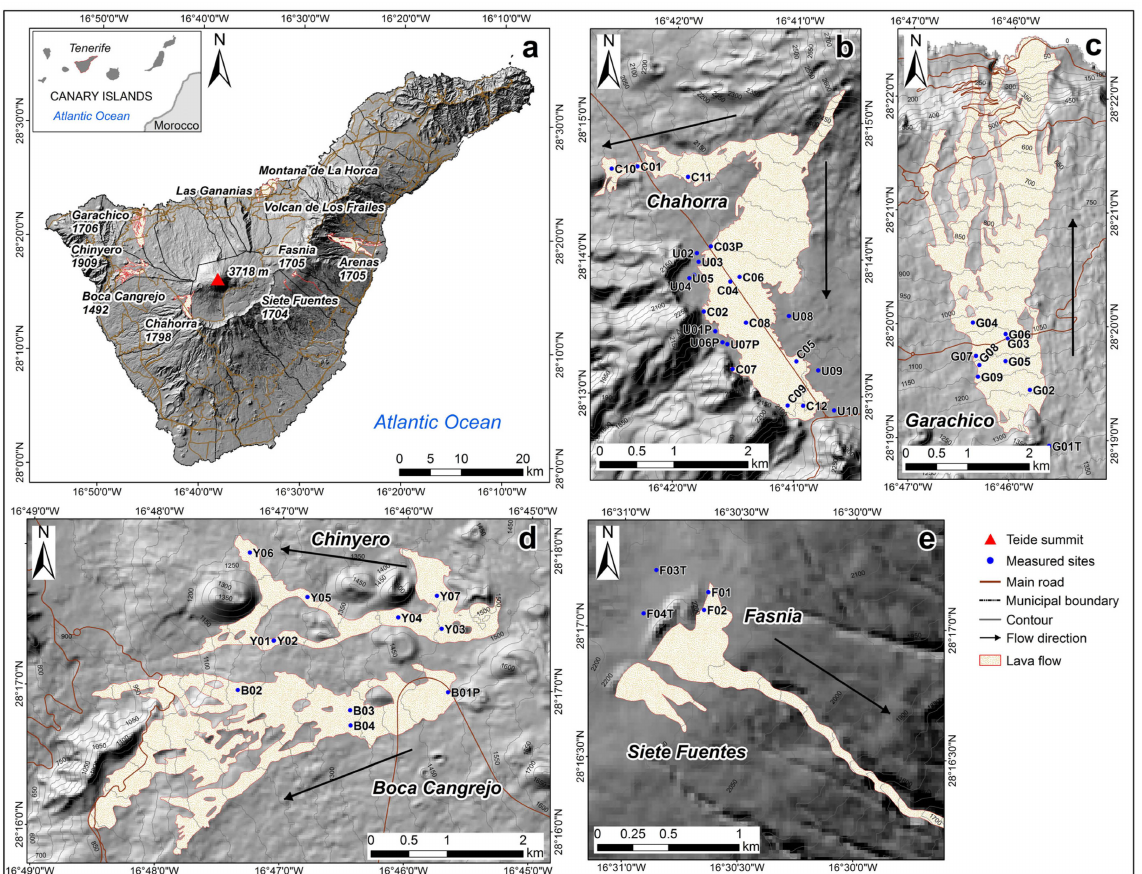
Figure 1. Location of studied lava flows on Tenerife Island and distribution of field spectroscopic measurements sites. A shaded relief image derived from a 25 m resolution DEM is overlaid with contour lines with an interval of 50 m and GIS data of roads and municipal boundaries (GIS data are freely available at [38]). A detailed description of these sites is given in Table A1. ( a ) Overview of the island; ( b ) Chahorra flow and surrounding sites on undated flows; ( c ) Garachico flow; ( d ) Chinyero (top) and Boca Cangrejo (bottom) flows; ( e ) Fasnia (top) and Siete Fuentes (bottom) lava flows and tephra deposit (sites F03T and F04T). For more information on these eruptions and how they were dated, the reader is referred to [36] and references